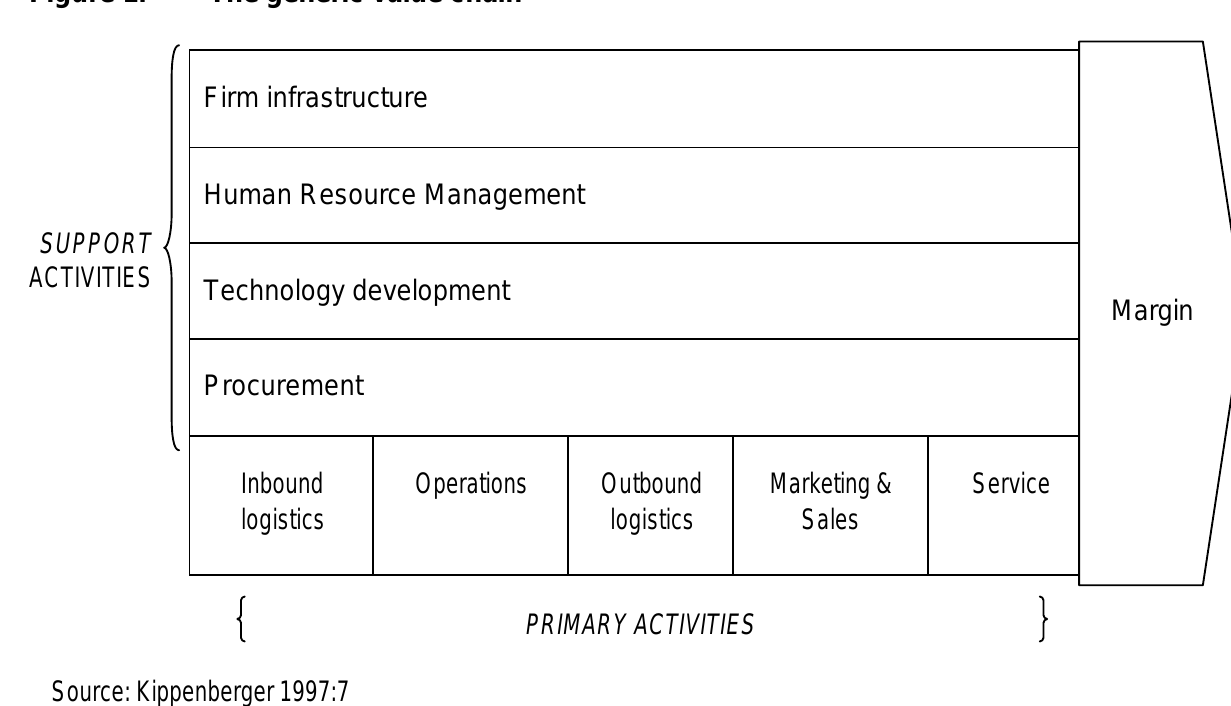
The generic value